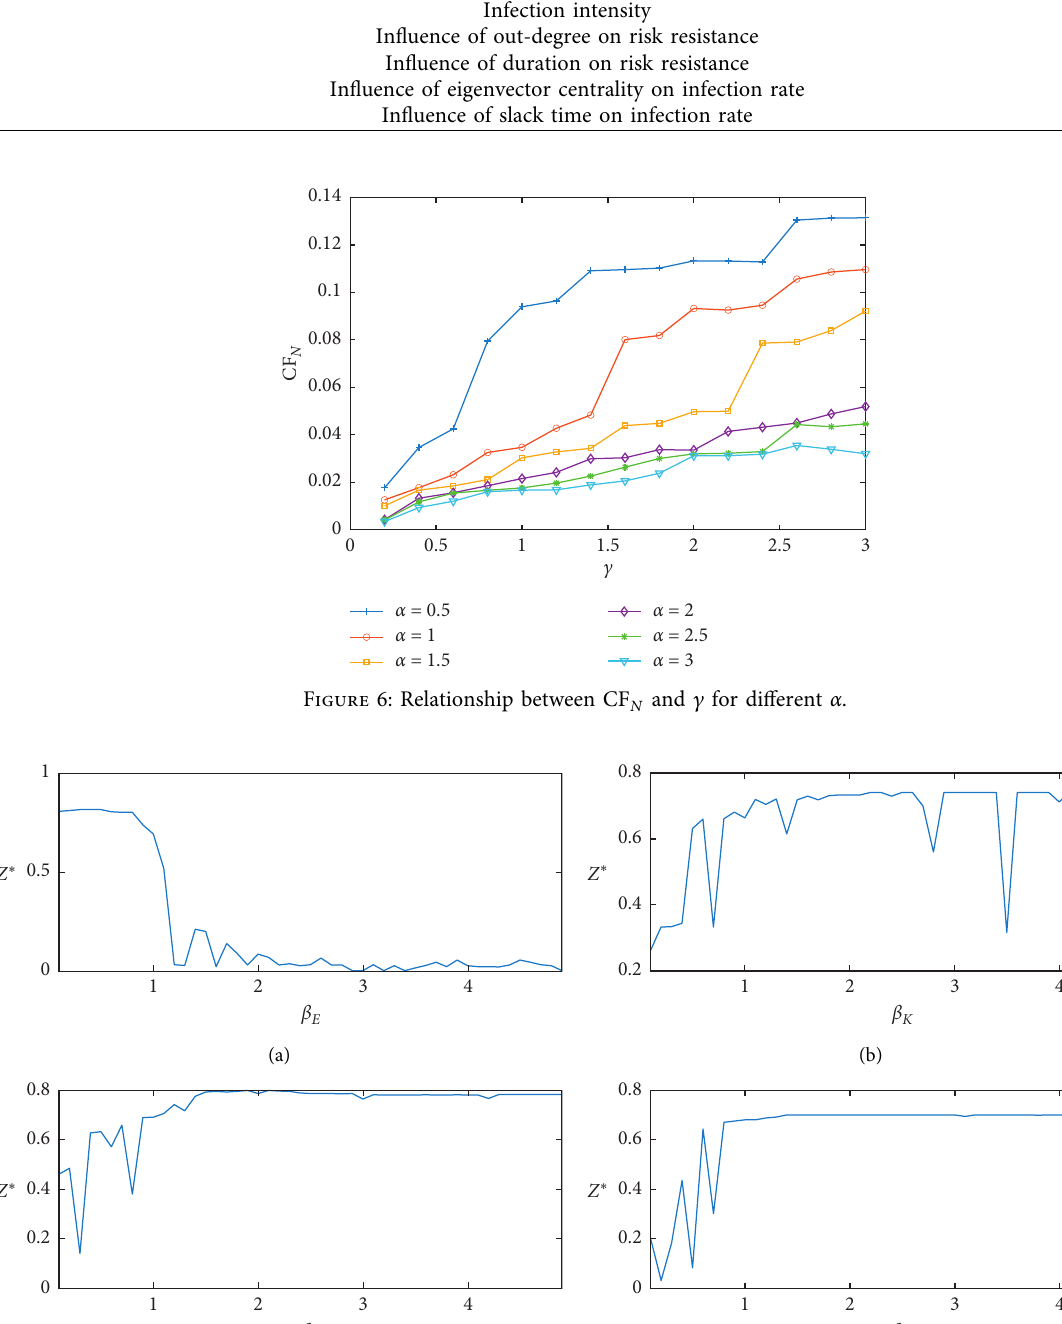
� 0 . 2 , c � 0 . 5). Relation between (a) Z ∗ and β